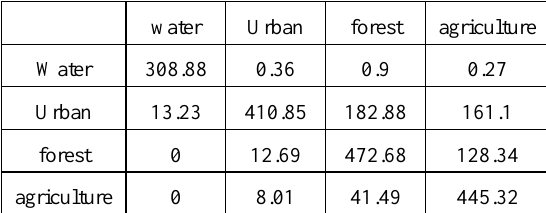
Table 1. Land use change from 2000 to 2018 (ha).